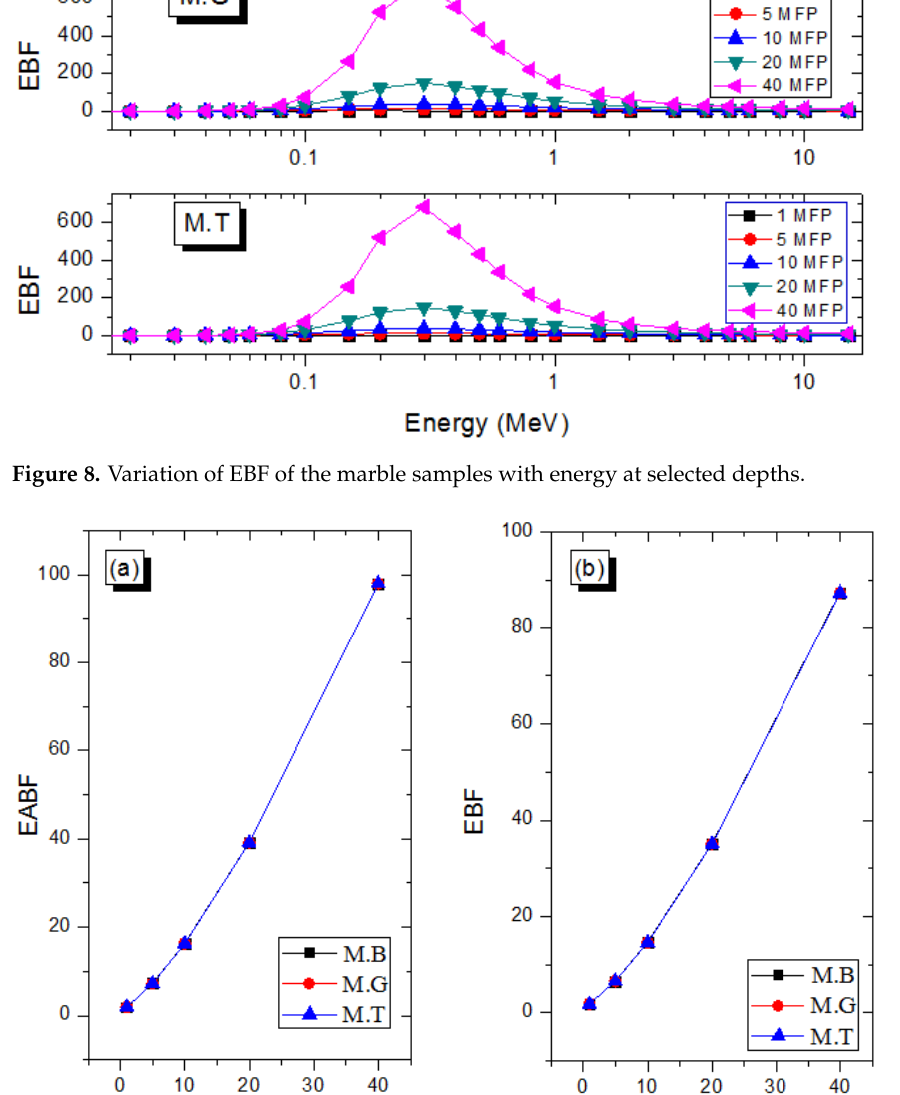
Figure 9. Variation of EABF ( a ) and EBF ( b ) with depth in the marble samples E = 1.5 MeV. The fast neutron removal cross section Σ R expresses the ability of the marbles to slow down fast neutrons through multiple scattering. It is the ability of the marbles to shield fast neutrons. The Σ R of the marbles, as shown in Figure 10, has value of 0.0975, 0.0956, and 0.0939 cm −1 for MB, MG, and MT, respectively. The trend of the Σ R is con- sistent with the density of the marble samples and also the partial density of the O atom in the samples. The partial density value for MB, Mg, and MT is 1.3601, 1.3259, and 1.2992 g/cm 3 , respectively. Compared to ordinary concrete with Σ R = 0.0937 cm −1 , the investi- gated marble samples have a better fast neutron shielding ability.